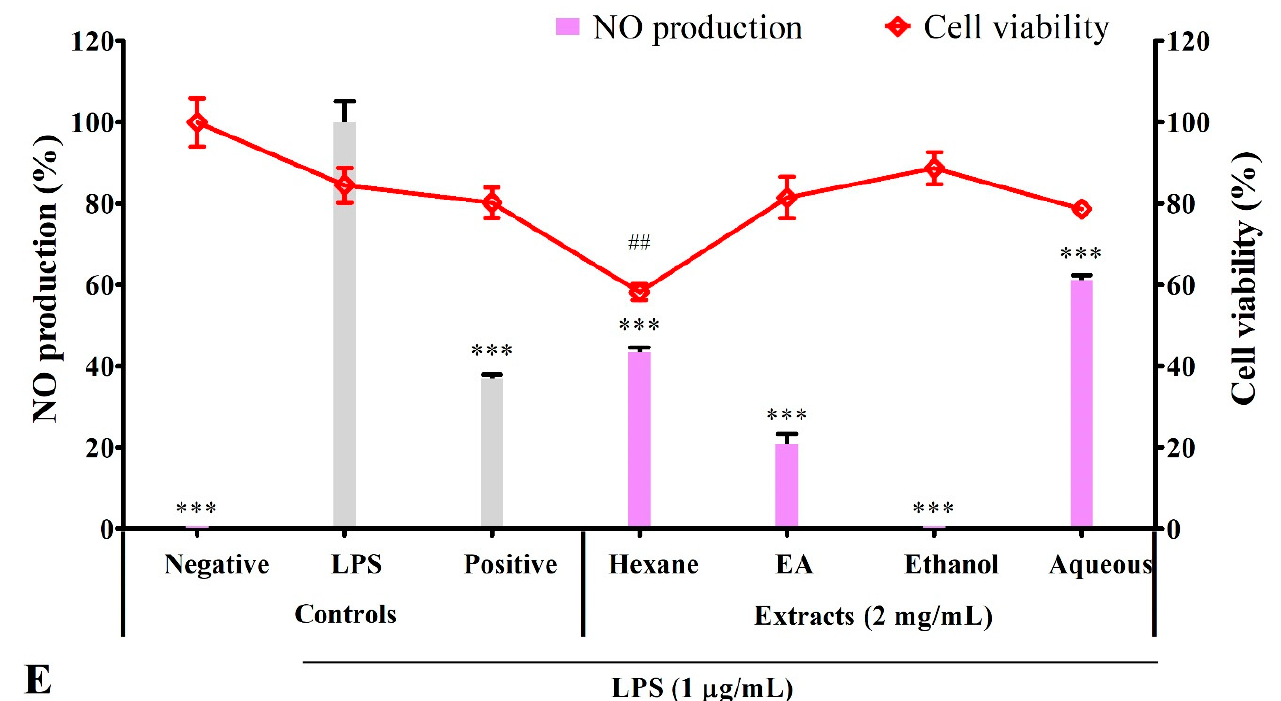
Figure 3. NO inhibitory activity of S. platensis solvent extracts in LPS-induced BV2 microglia. Dose- dependent effect of ( A ) hexane, ( B ) ethyl acetate, ( C ) ethanol, ( D ) aqueous extracts, and ( E ) the effect of all solvent extracts at 2 mg/mL on the NO production (bar chart) and cell viability (line chart). NO production and cell viability were expressed as a percentage of the LPS and negative control, respectively. Data represented the mean ± SE ( n = 3). *** p ≤ 0.001 and ** p ≤ 0.01 significant in NO production; ### p ≤ 0.001, ## p ≤ 0.01 and # p ≤ 0.05 significant difference in cell viability relative to the LPS control by Dunnett’s multiple comparison test. L-NAME served as the positive control. EA: ethyl acetate.